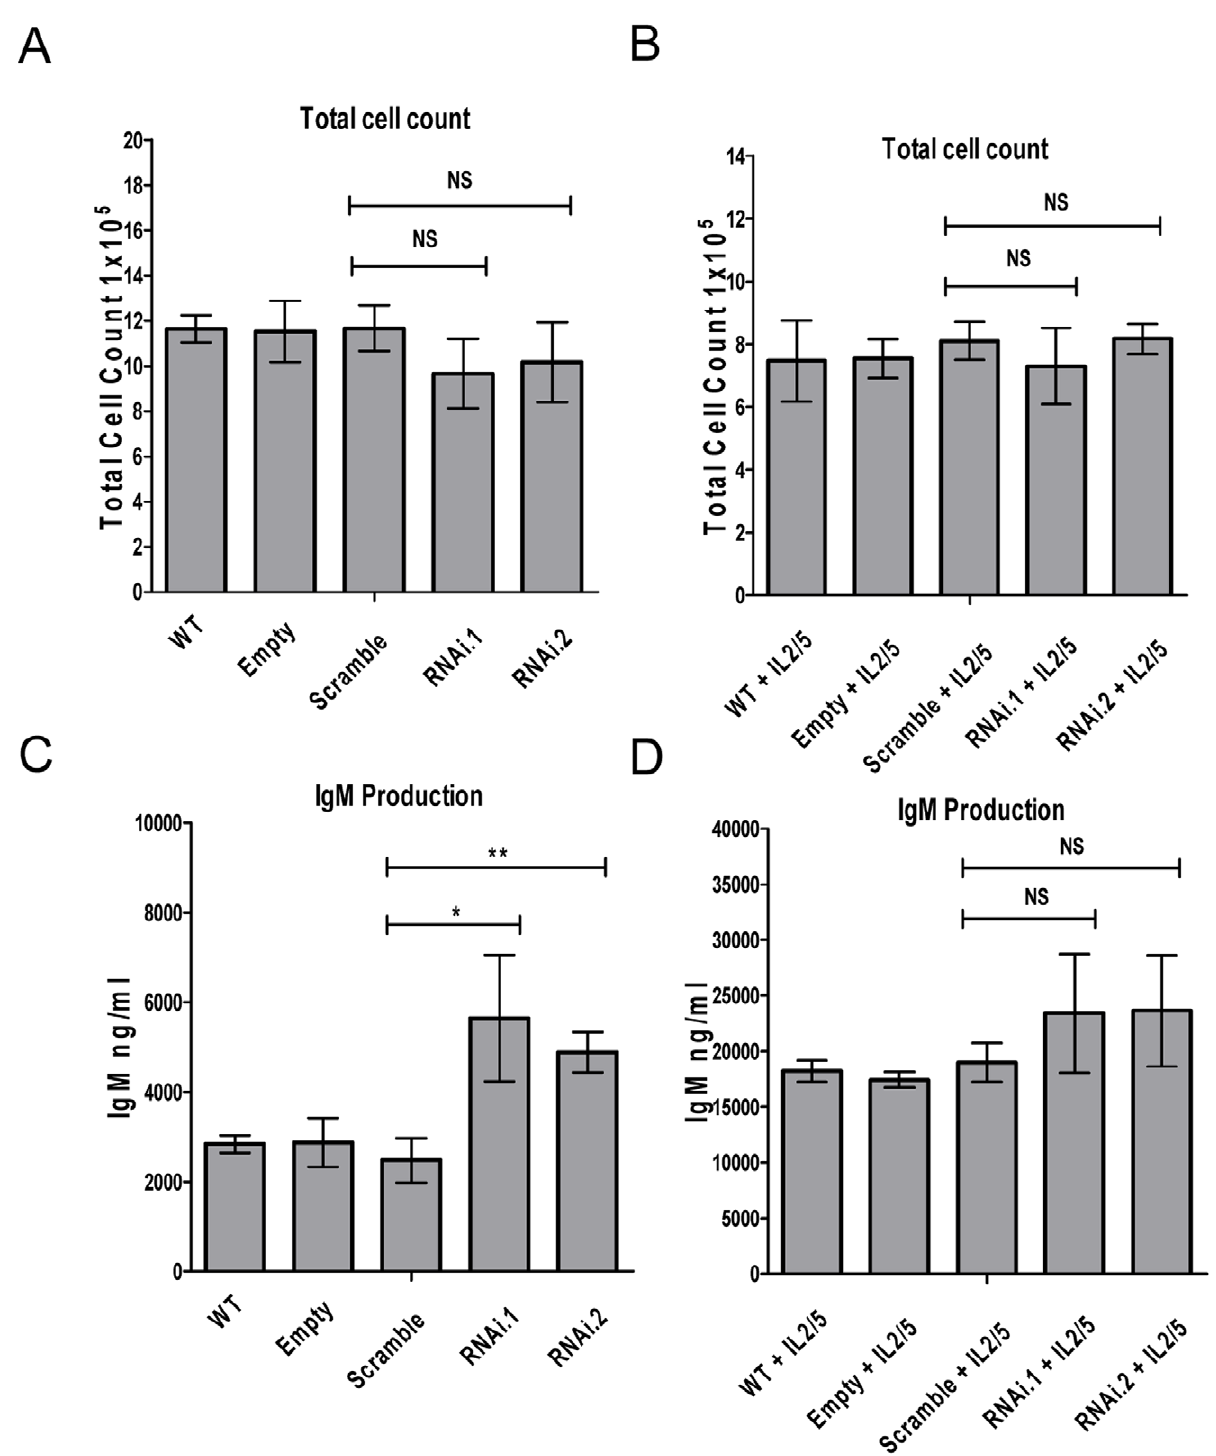
Figure 5. Lentiviral-mediated knockdown of ZFP36L1 expression in BCL1 cells promotes plasmacytoid differentiation by inducing IgM production. Cell numbers in the absence (A) and presence (B) of cytokines (IL-2 and IL-5) in pSicoR.zfp36l1.RNAi1 and pSicoR.zfp36l1.RNAi2 BCL1 cells compared to compared to wild-type, empty vector or pSicoR.scramble.RNAi infected cells. Cells numbers were counted in quadruplicate 4 days after seeding 2 6 10 5 /ml cells on day 0 in flasks in the absence or presence of cytokines (IL-2 20 ng/ml and IL-5 5 ng/ml). Mean 6 SD (n=3) are shown for three independent cell lines generated for each of the lentivirus infected cells. IgM secretion (ng/ml) measured by ELISA, 4 days after the start of the culture, in the absence (C) and presence (D) of cytokines (IL-2 20 ng/ml and IL-5 5 ng/ml) in pSicoR.zfp36l1.RNAi1 and pSicoR.zfp36l1.RNAi2 BCL1 cells compared to compared to wild-type, empty vector or pSicoR.scramble.RNAi infected cells. Mean 6 SD (n=3) are shown for three independent cell lines generated for each of the lentivirus infected cells. **=p , 0.01, *=p , 0.05 as determined by t-test.